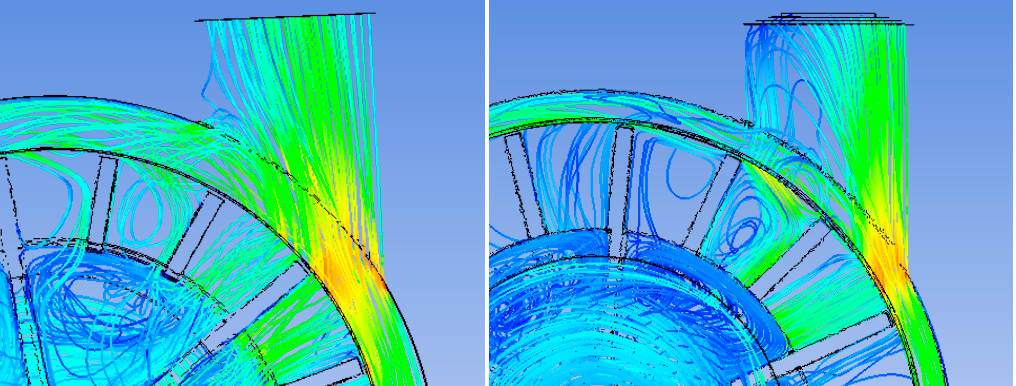
Figure 9. Liquid jet profiles in the area of the pump outlet port for both impeller designs: primary impeller (left), impeller with larger diameter (right).